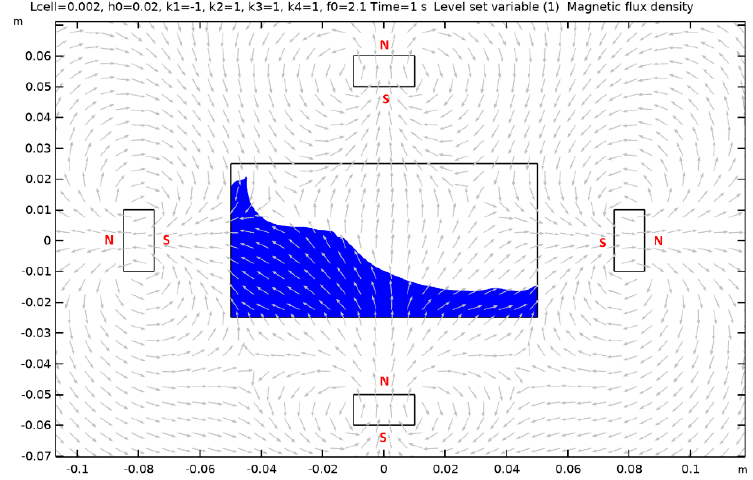
Figure A6. Case 7.